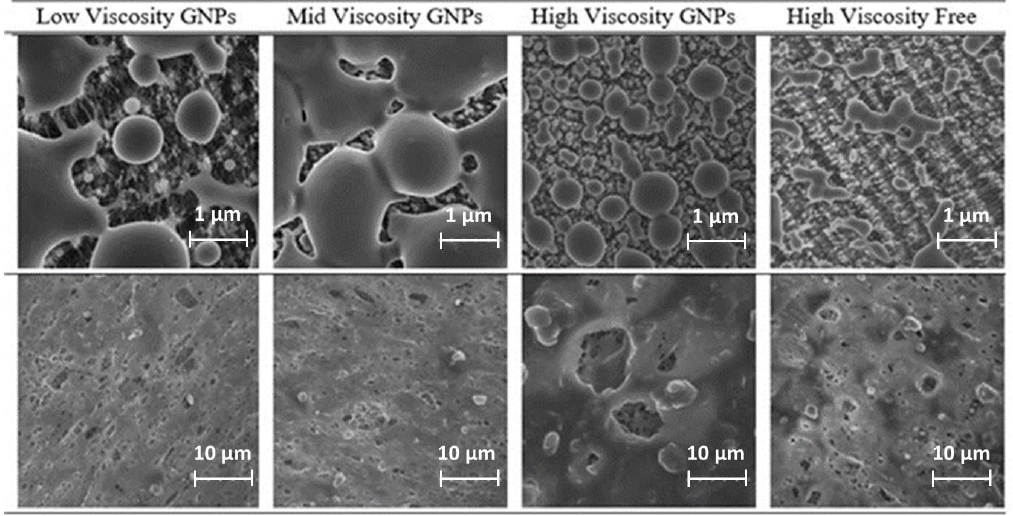
Figure 10. SEM images for the PTFE ( upper row ) and PVC ( lower row ) filters collected. Due to the smoother surface of the PVC filter, particles are more easily deposited in them, while in the PTFE, mainly drops remain, despite having a smaller pore size. The gathered particles in PVC filters are integrated onto a layer of paint in most cases.